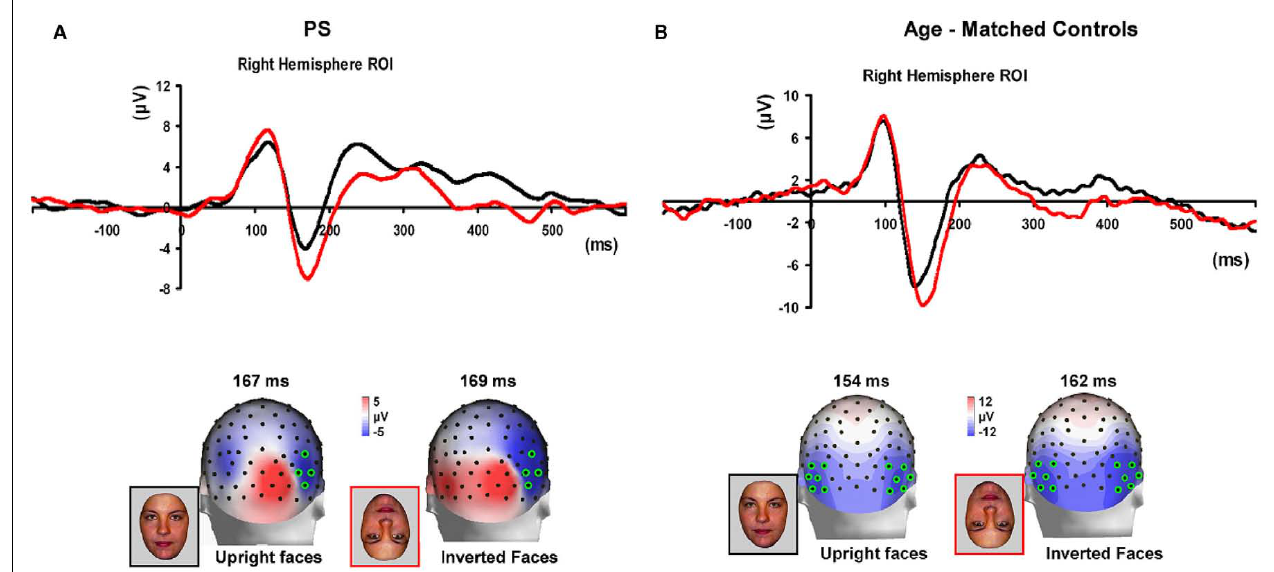
FIGURE 7 | (A) The effect of face inversion on the right N170 for the four age-matched normal controls tested in Experiment 2.The N170 was larger in amplitude and delayed to inverted faces, as previously shown in many studies. (B) .The inversion increase and delay as observed on the right hemisphere N170 for PS.